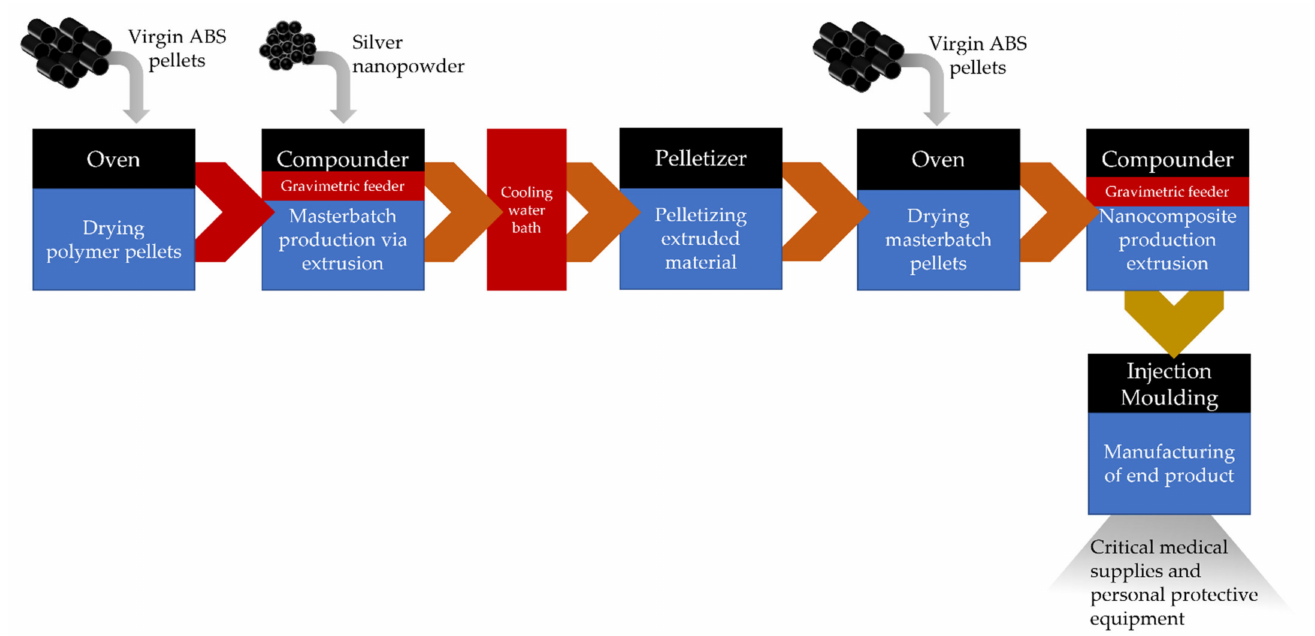
Figure 1. Process flow diagram of the manufacturing pilot line.